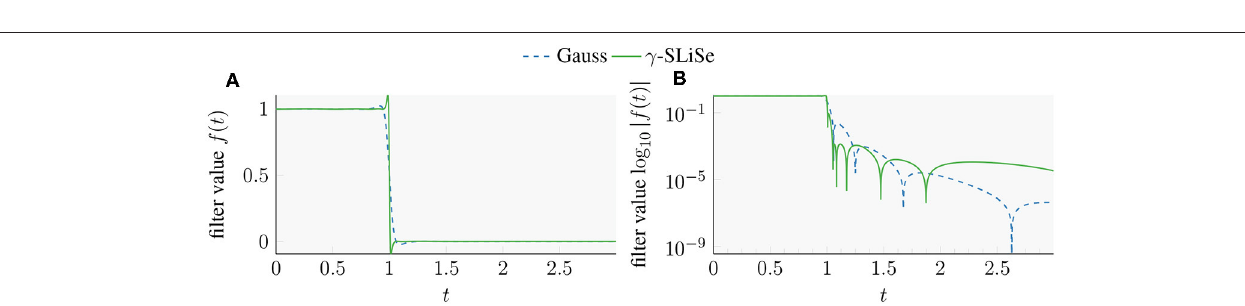
FIGURE 3 | Plots of the Gauss filter and our replacement candidate, γ -SLiSe. Both filters have 16 poles and coefficients. (A) Linear-scale plot. (B) Semi-log